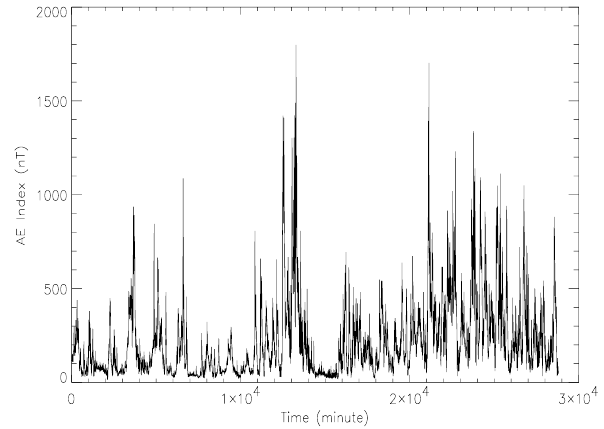
Fig. 1. The auroral electrojet index AE for January 1983 at 1min resolution. The sharp spikes represent substorms and the strong substorms usually occur during space storms.